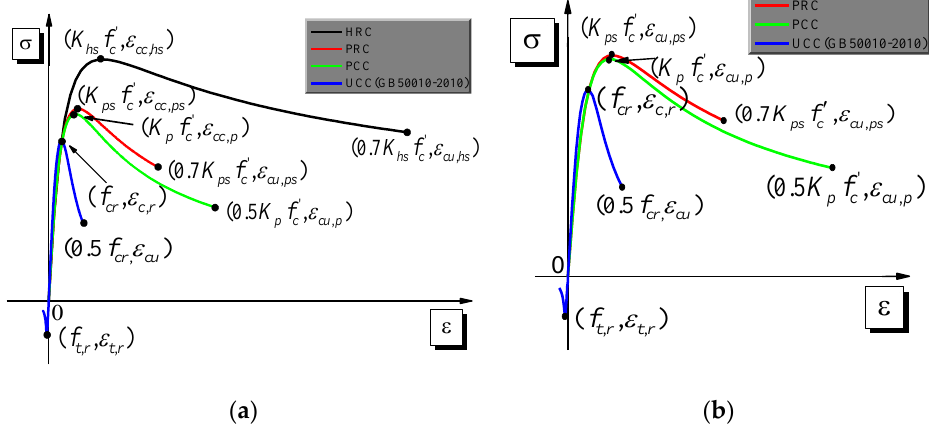
Figure 2. The stress–strain constitutive relationship of different regional partitions: ( a ) concrete in the column; ( b ) concrete in the beam.